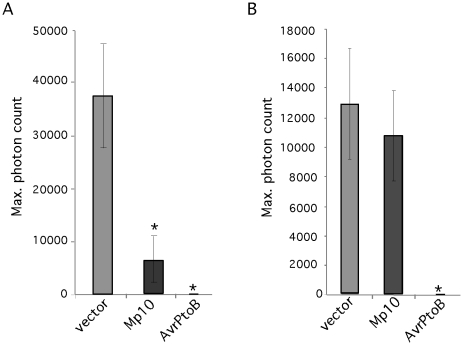
Mp10 suppresses the oxidative burst induced by flg22, but not chitin, in N. benthamiana.The induction of reactive oxygen species (ROS) induced by the flg22 and chitin was measured using a luminol-based assay. (A) The ROS response induced by flg22 in N. benthamiana leaf discs overexpressing Mp10, AvrPtoB (positive control) and the vector control upon agroinfiltration. The maximum photon count is based on the average of 8 leaf discs. The experiment was repeated 3 times with similar results. Error bars indicate standard error. Asterisks indicate statistical significance compared to the vector control (p≤0.043) (B) The ROS response induced by chitin in N. benthamiana leaf discs overexpressing Mp10, AvrPtoB (positive control) and the vector control upon agroinfiltration. The maximum photon count is based on the average of 8 leaf discs. The experiment was repeated 3 times with similar results. Error bars indicate standard error. Asterisks indicate statistical significance compared to the vector control (p≤0.028).